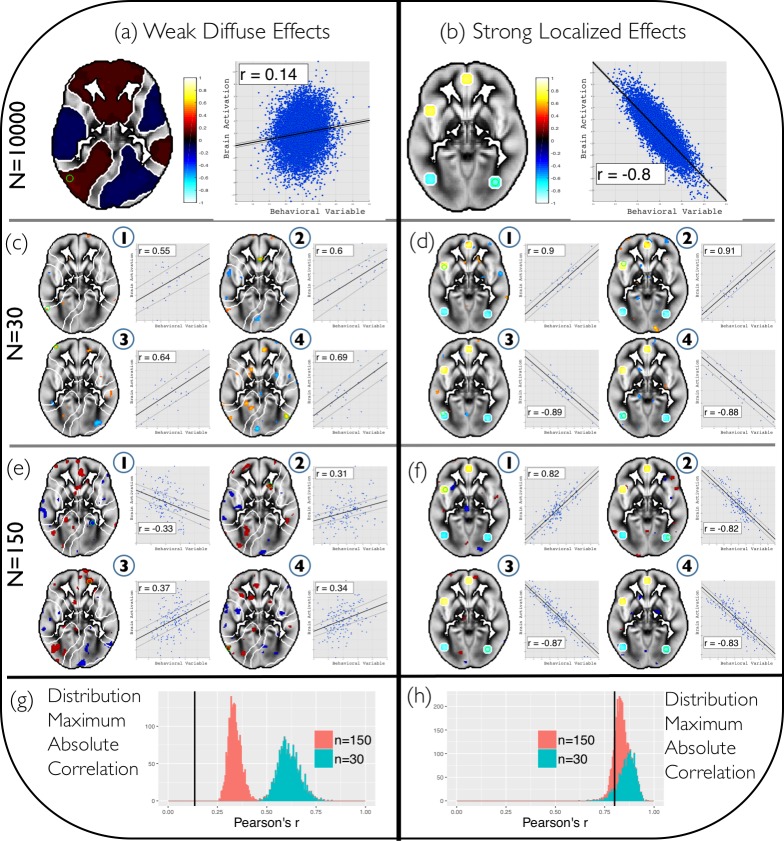
Examples of the sampling simulation.Two different brain-behavior correlation distributions (full sample n = 10.000): (a) Weak Diffuse (WD) and (b) Strong Localized (SL). The scatter plots display the voxel (indicated by a green circle in the image) with the strongest absolute correlation between its brain activity (y-axis) and the behavioral variable (x-axis). The color bar indicates the effect size (Pearson’s r). From these two full samples, 4 random subsamples are drawn with two different sample sizes: (c) n = 30 from the WD full sample (d) n = 30 from the SL full sample (e) n = 150 from the WD full sample (f) n = 150 from the SL full sample. For each subsample a p < .01 uncorrected threshold is applied. The distribution of the maximum effect sizes (absolute values) obtained from the subsampling procedure are shown for the (g) WD scenario and (h) SL scenario. The thick black lines indicate the maximum correlation of the full sample. Small samples (n = 30) of the WD scenario show a large discrepancy (overestimation of the effect sizes and underestimation of the spatial extend of brain-behavior correlations) with the full sample effects, and the WD subsamples appear more similar to the SL scenario. Larger samples of the WD scenario (n = 150) show less, but still substantial discrepancy with the full sample effects. For the SL scenario there is a small discrepancy between subsamples of either sample size and the full sample effects.